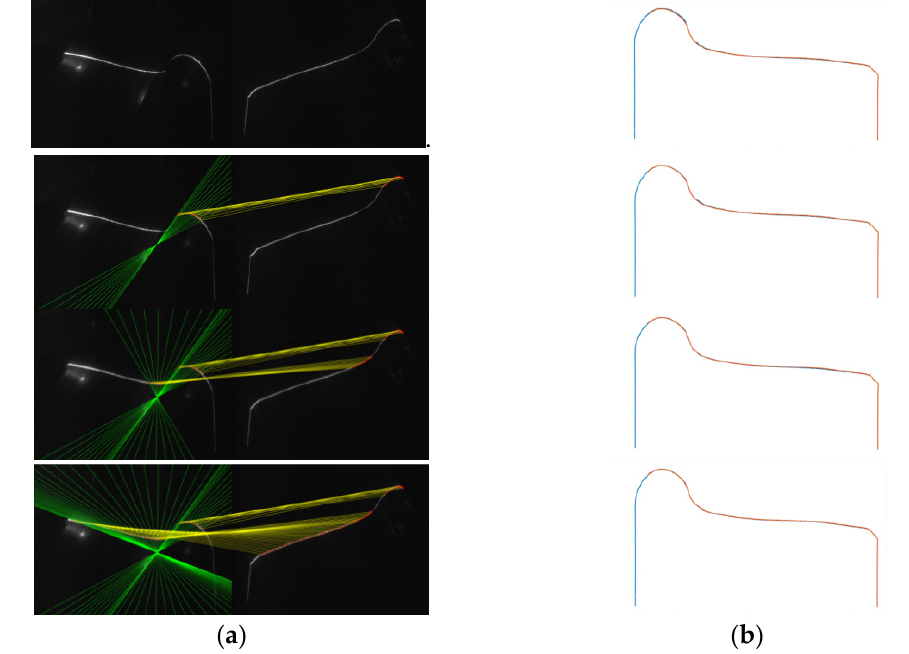
Figure 10. Calibration revising results based on different amounts of matching points. ( a ) Matching points of two images (matching points are connected by yellow lines and green lines are epipolar lines). ( b ) Reconstructed profiles after calibration parameters being revised according to the matching points.